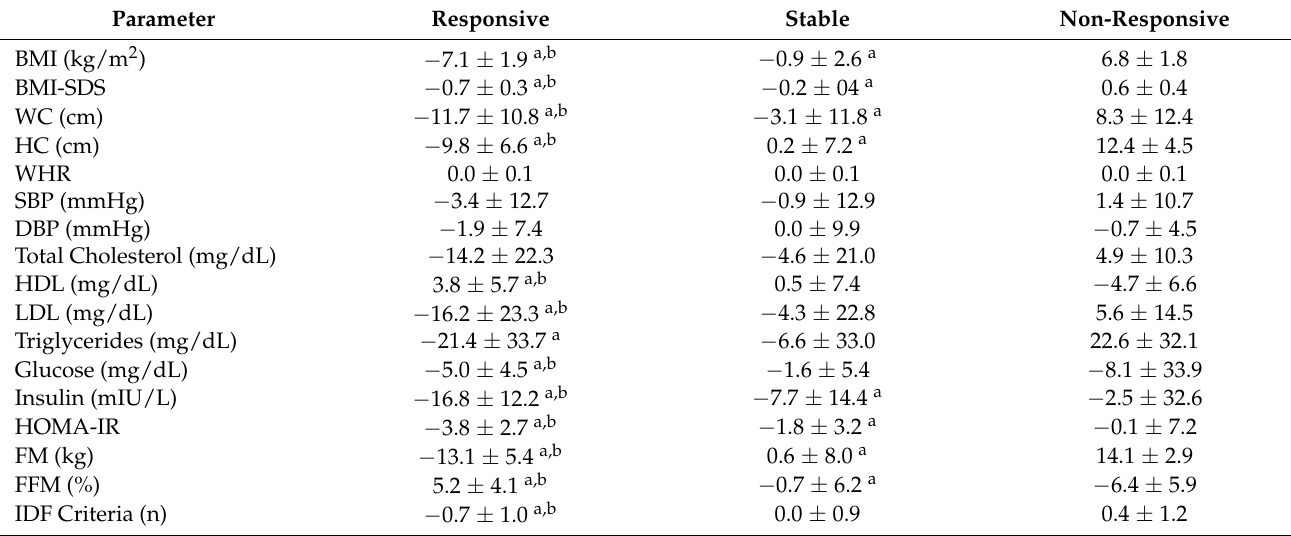
Table 2. Changes in auxometric and metabolic parameters in children and adolescents with obesity, defined as responsive, stable or non-responsive in accordance with ∆ BMI (i.e., < − 5, > − 5 and <5 or >5 kg/m 2 , respectively). Parameter Responsive Stable